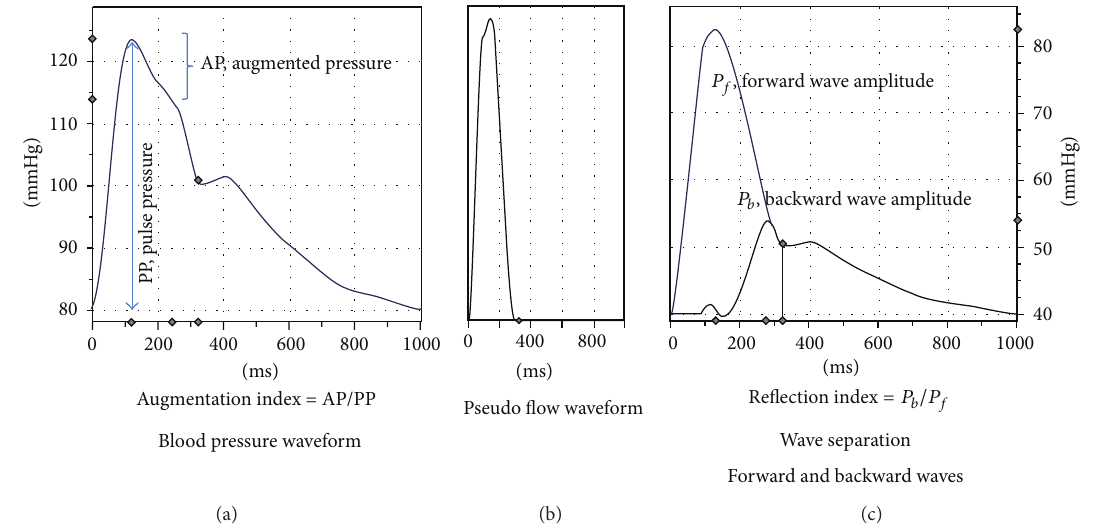
Figure 3: CCA pressure waveform (a) and pseudo flow waveform (b) used for wave separation analysis (c).